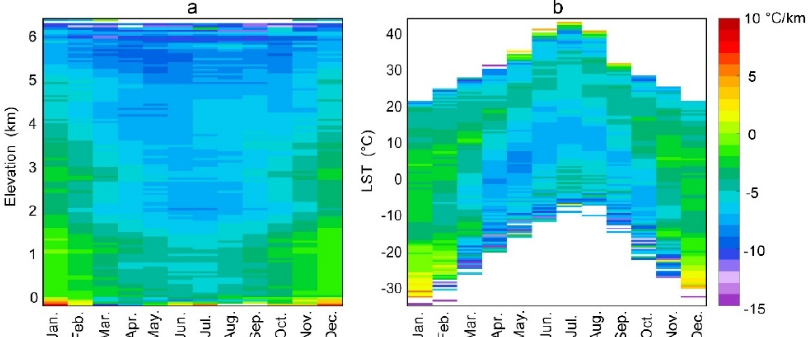
Figure 8. Profile of the monthly average TLR with elevation ( a ) and LST ( b ). The color bar shows twenty-five levels of TLR with − 15 < Γ ≤ 10 ◦ C/km. The spacing of elevation was 50 m ( a ) and that of LST was 1 ◦ C ( b ). The value of a grid was the mean of the TLR of the image pixels where the TLRs ranged within the grid bound. If the number of above-mentioned image pixels was less than two, the value was assigned as null.